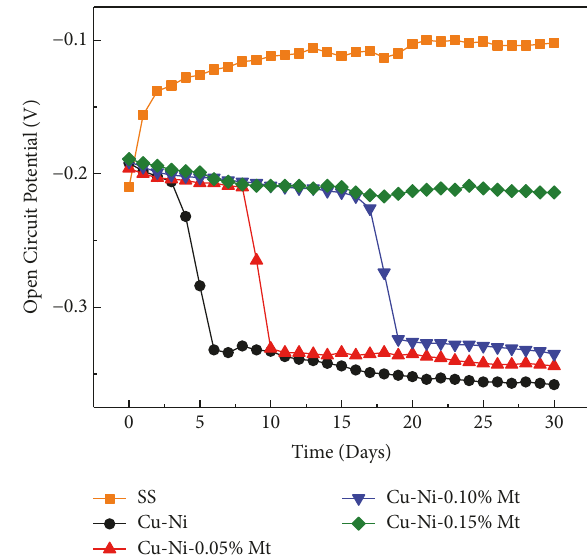
Figure 6: Plot of the immersion test for the 90-10 Cu-Ni and Cu- Ni-Mt nanocomposite coatings measured by OCP versus time for 30 days in Burkholder’s Formula B